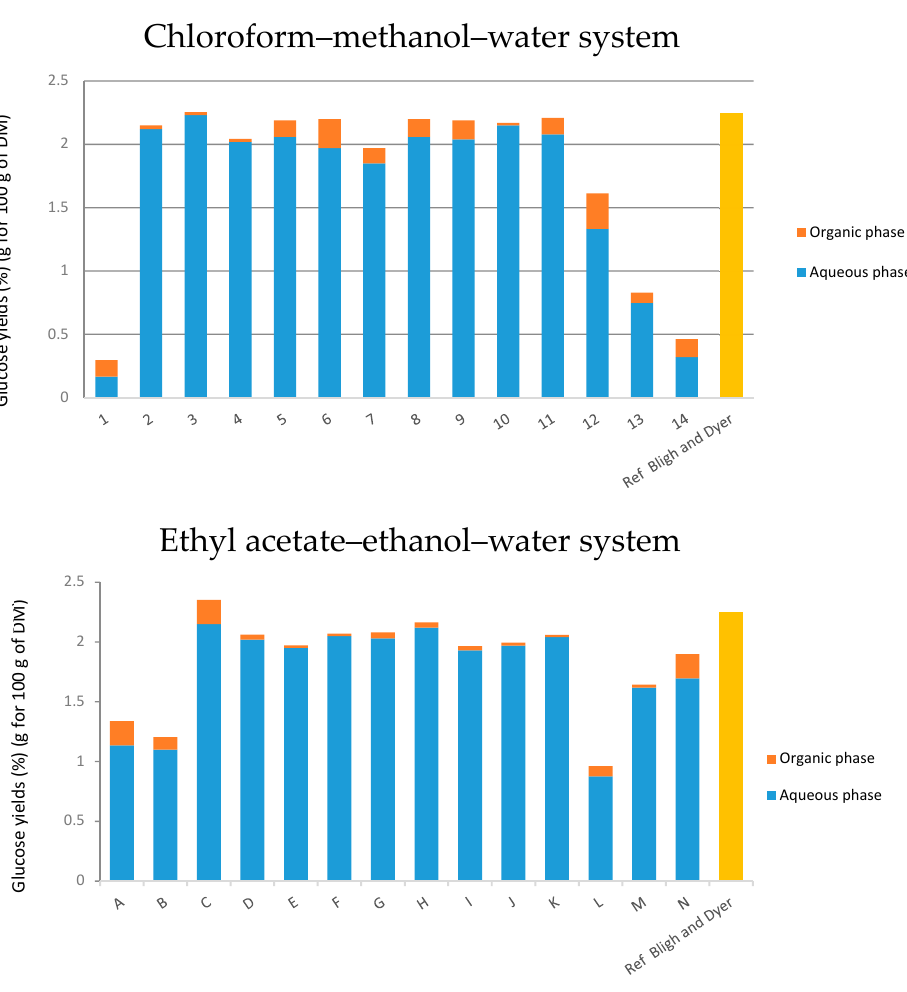
Figure 6. Extraction yields of glucose in both systems. Yields obtained by UV spectrometry in aqueous and organic phases.